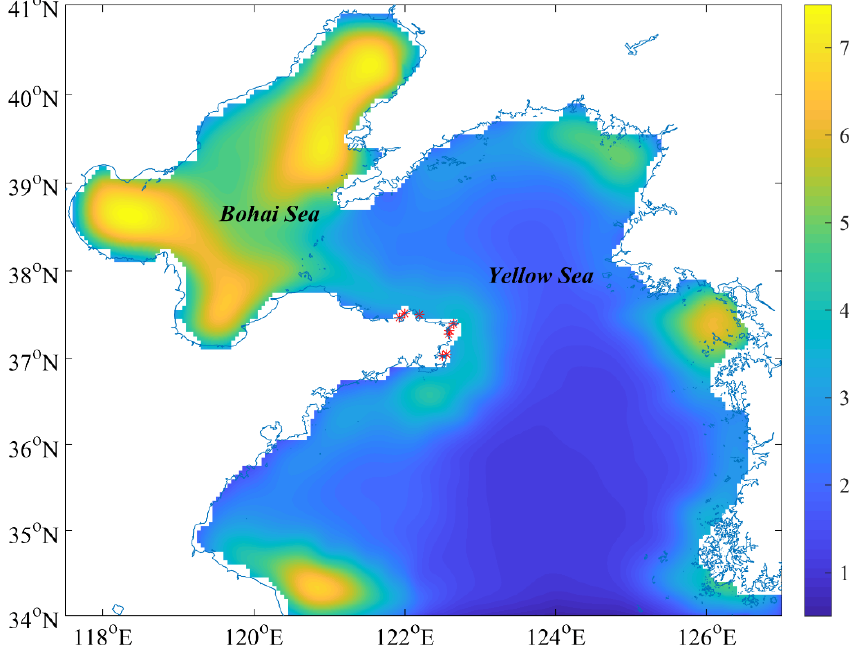
Figure 9. The model's simulated results of monthly mean chlorophyll-a concentration in August Figure 9. The model’s simulated results of monthly mean chlorophyll-a concentration in August (Unit: mmol/L). Red asterisks represent the location of marine ranches. (Unit: mmol/L). Red asterisks represent the location of marine